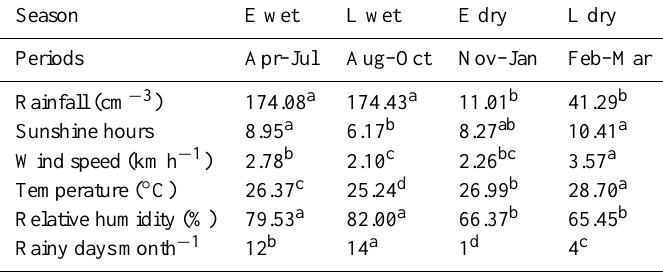
Table 1. Mean seasonal weather parameters of Ibadan